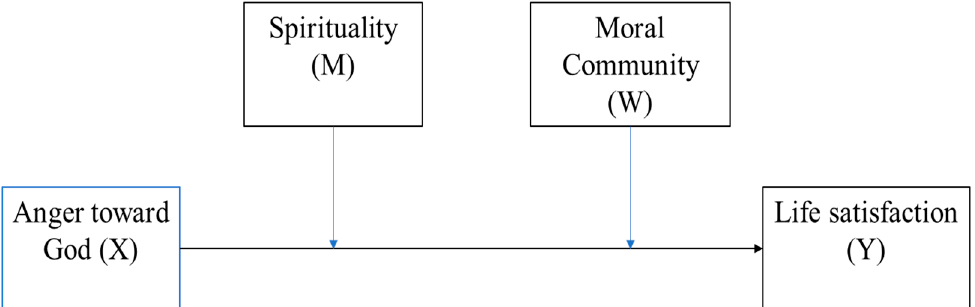
Figure 1. Conceptual model of the main hypotheses.